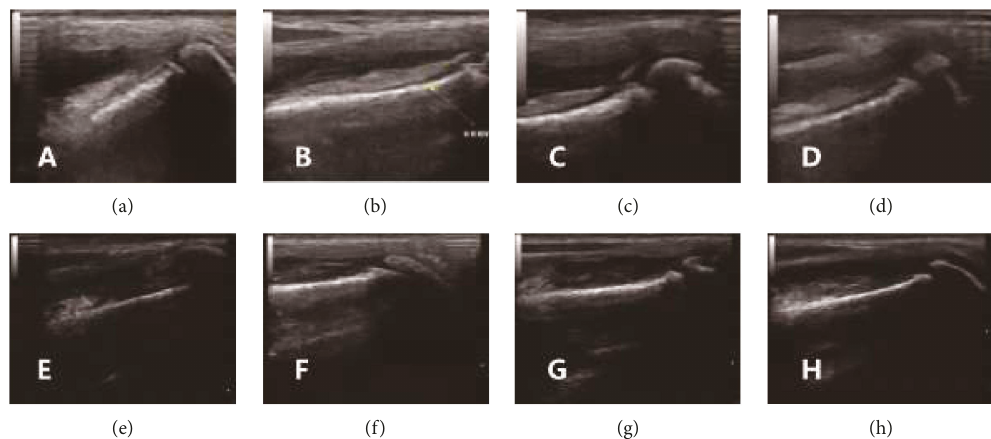
Figure 4: B ultrasonography assessment of canine arthritis after the treatment: (a) 3 days after cell therapy, (b) 7 days after cell therapy, (c) 14 days after cell therapy, (d) 28 days after cell therapy, (e) 3 days after treatment in the untreated control group, (f) 7 days after treatment in the untreated control group, (g) 14 days after treatment in the untreated control group, and (h) 28 days after treatment in the untreated control